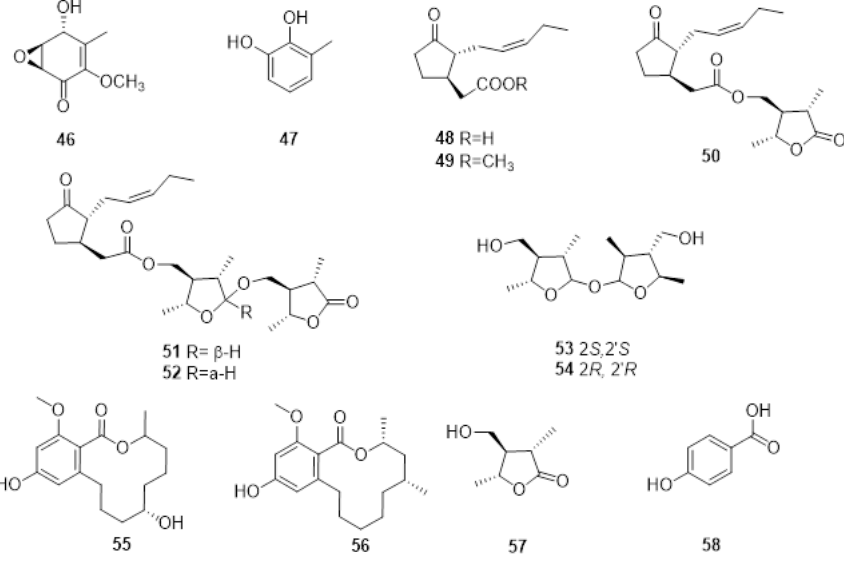
Figure 5. Structure of cyclobotryoxide ( 46 ), 3-methylcatechol ( 47 ), jasmonic acid ( 48 ), jasmonic acid methyl ester ( 49 ), lasiojasmonate A ( 50 ), lasiojasmonates B and C ( 51 , 52 ), lasiolactol A and B ( 53 , 54 ), botryosphaeriodiplodin ( 55 ), (5R)-5-hydroxylasiodiplodin ( 56 ), (3S,4R,5R)-4-hydroxymethyl-3,5-dimethyldihydro-2-furanone ( 57 ) and p-hydroxybenzoic acid ( 58 ). In the same year, 24 fungal isolates representing the eight most widespread and vir-